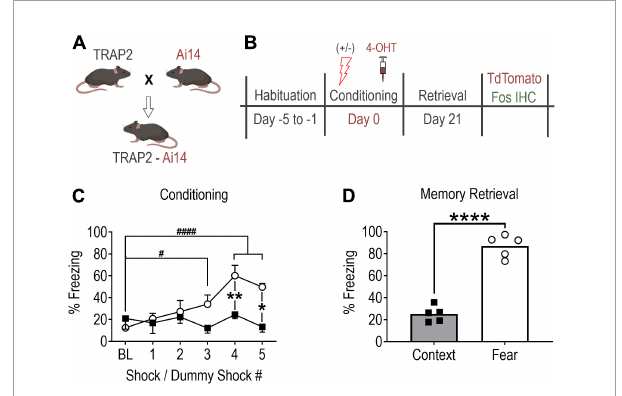
FIGURE1 Contextual fear memory formation promotes robust remote